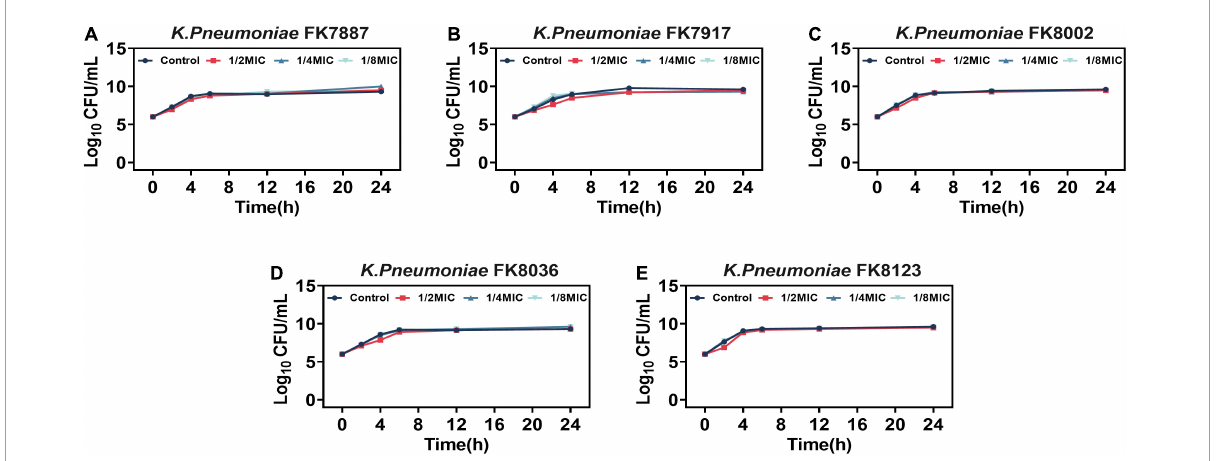
FIGURE2 (A-E) Effects of different concentrations of chlorogenic acid (CA) on the growth of five carbapenem-resistant Klebsiella pneumoniae (CRKP) strains. Different color represents different concentrations of CA. The dark blue represents the control group, the red represents 1/2 MIC, the light blue represents 1/4 MIC, and the green represents 1/8 MIC.